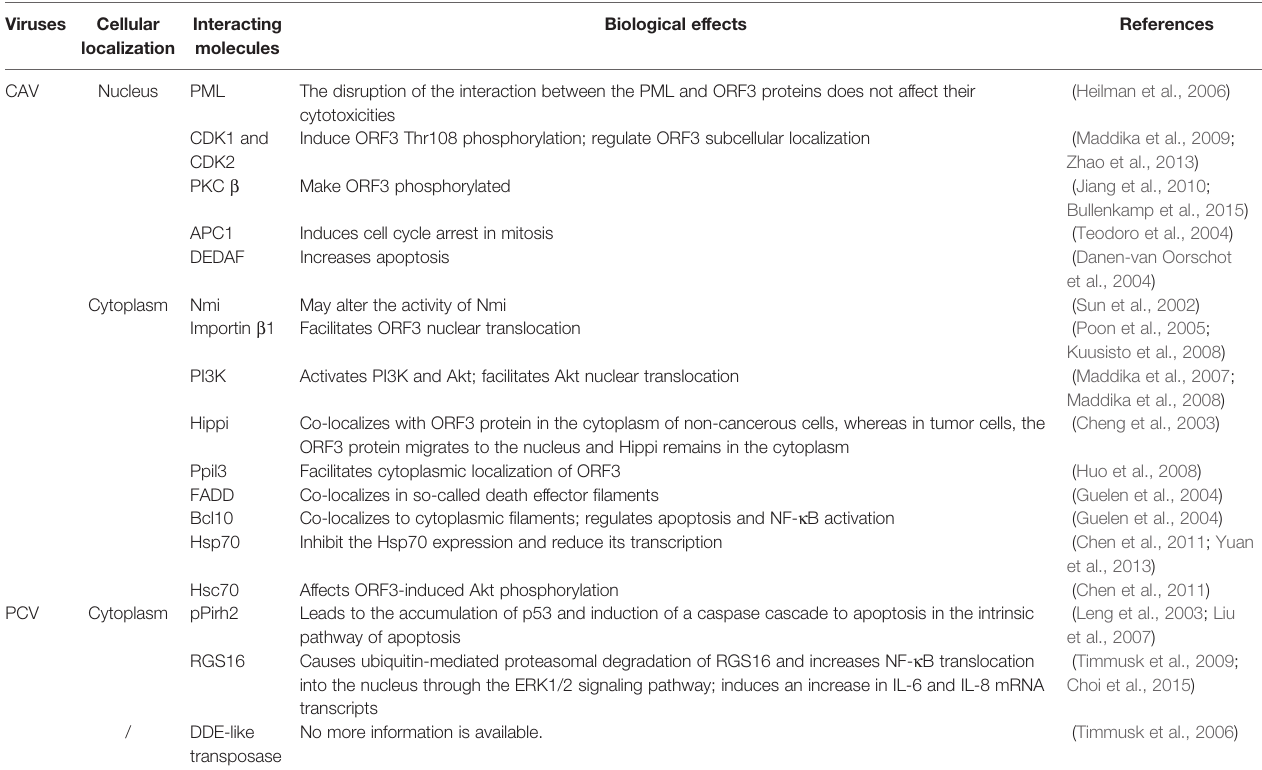
TABLE 1 | Molecules that interact with CAV and PCV ORF3 proteins.